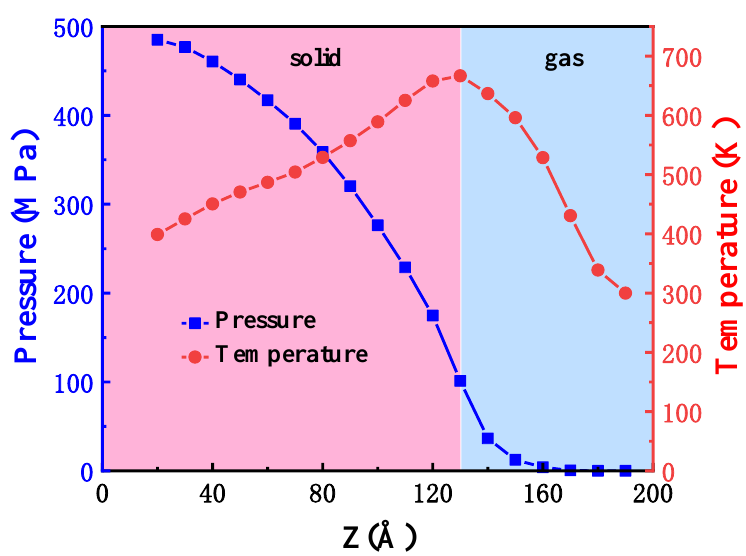
Figure 3. Pressure and temperature distribution along the plate surface solved by MD simulation. The blue square denotes pressure, and the red circle denotes temperature.